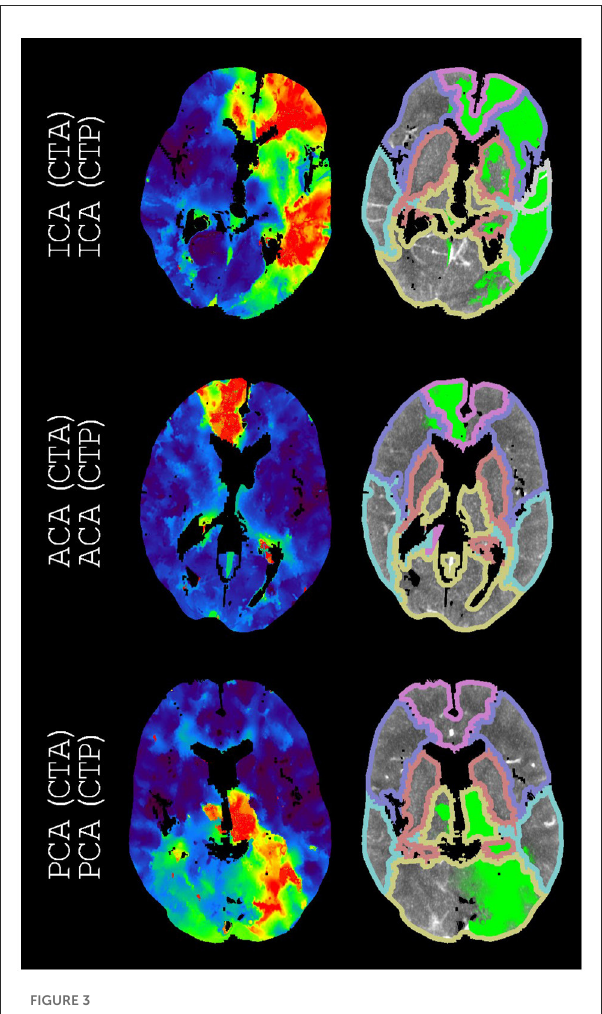
FIGURE3 Examples of annotations (CTA) and indications (CTP) that match arteries other than the middle cerebral artery. On the left, time-to-peak perfusion maps are shown. On the right, the hypoperfused regions and the downstream regions (according to Figure 1) are shown. For each example, we only regarded the M3 downstream region with the highest intersection-over-union. The only displayed M3 downstream region is the superior temporal